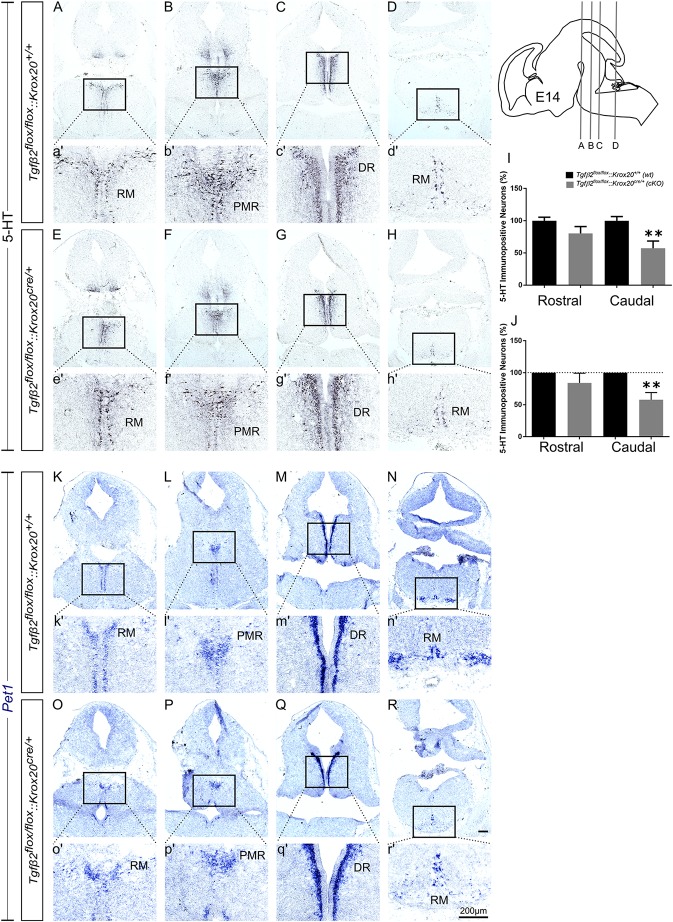
Phenotype analysis of Tgfβ2flox/flox:Krox20cre/+ hindbrain at embryonic day 14 (E14). Immunoperoxidase light microscopy for the rostral serotonergic neuron subgroups DR (C,G), and PMR (B,F) and of the caudal serotonergic neurons of RM (A,E,D,H) of Tgfβ2flox/flox:Krox20+/+ (wt) and Tgfβ2flox/flox:Krox20cre/+ (cKO) at E14. (a′–h′) represent higher magnification of the respective black-boxed areas in A-H. 5-HT positive cell counts (I,J) revealed significant decrease in the number of caudal hindbrain serotonergic neurons of RM between Tgfβ2flox/flox:Krox20cre/+, and wild type (wt) (∗∗p < 0.01, using the unpaired two-tailed Student’s t-test n = 6). Data are given as mean ± SEM, normalised to the mean of counts in wt set to 100 (I) or to the mean of wt littermate set to 100 (J). ISH for expression of the serotonergic marker Pet1
(K–R) using antisense probes on coronal fixed tissue cryosections from wt and Tgfβ2flox/flox:Krox20cre/+. (k′–r′) Represent higher magnification of the respective black-boxed areas in (K–R). Scale bar: 200 μm.